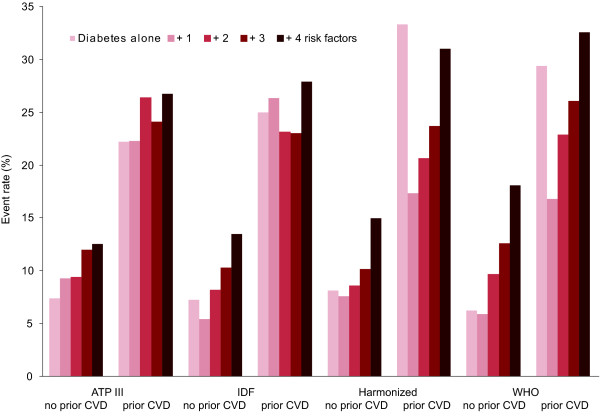
Cardiovascular disease event rates according to the number of additional metabolic syndrome components (risk factors) at baseline in relation to the ATPIII, IDF, harmonized, and WHO categories in patients allocated to placebo without (n = 3837) or with (n = 1063) prior cardiovascular disease. Apparent high event rates in the groups with no additional risk factors by the harmonized and WHO definitions are an artifact of low patient numbers.